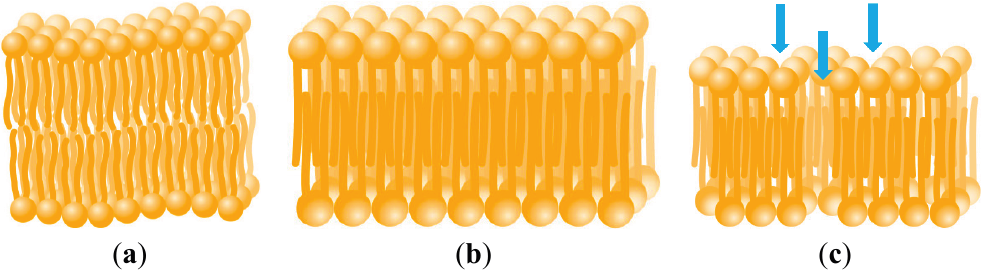
Figure 3. Bilayer structure of phospholipid membrane ( a ); Exposure to Cu 2+ reduces membrane fluidity resulting in densely-packed lipid regions [46] ( b ); and can also cause the formation of pores [55], indicated by blue arrows ( c ).